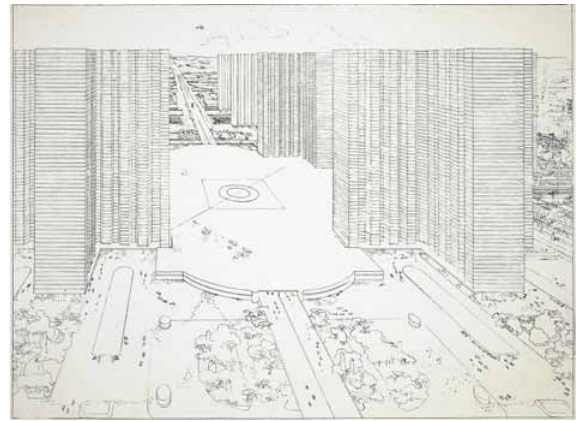
fig. 5. new view of Contemporary City for Three Million Inhabitants drawn in 1925. flC30850 ©